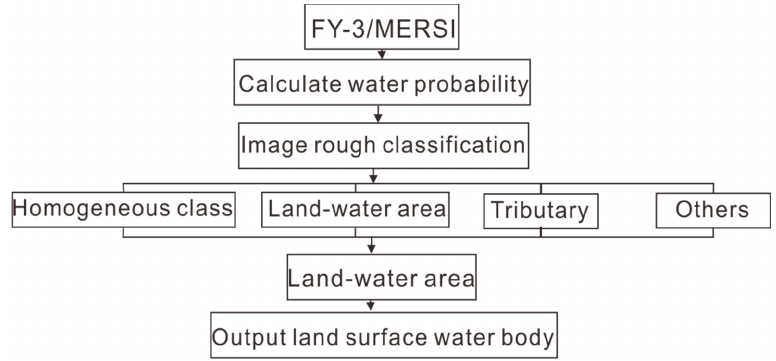
Figure 3. The flow chart of spectral matching based on discrete particle swarm optimization (SMDPSO).